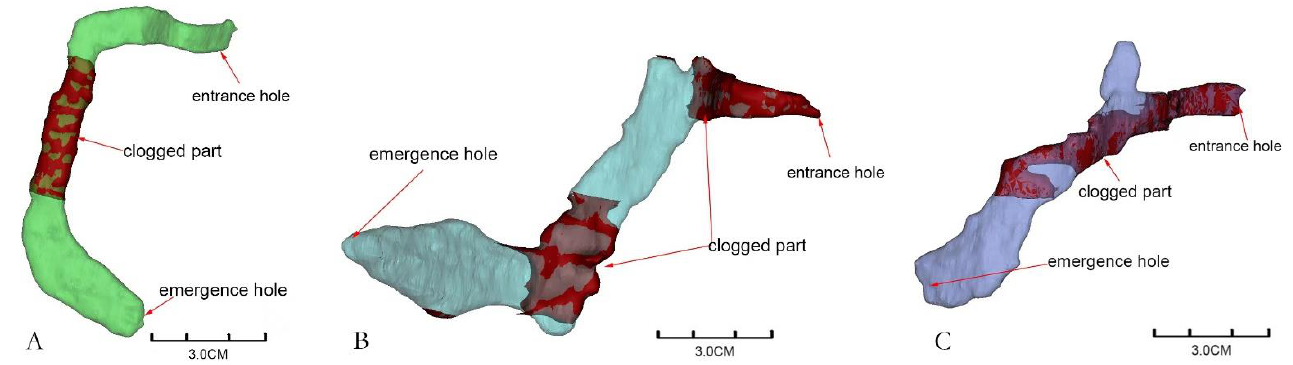
Figure 3. Gallery types of Monochamus alternatus (( A ): C-shaped, ( B ): S-shaped, ( C ): Y-shaped).